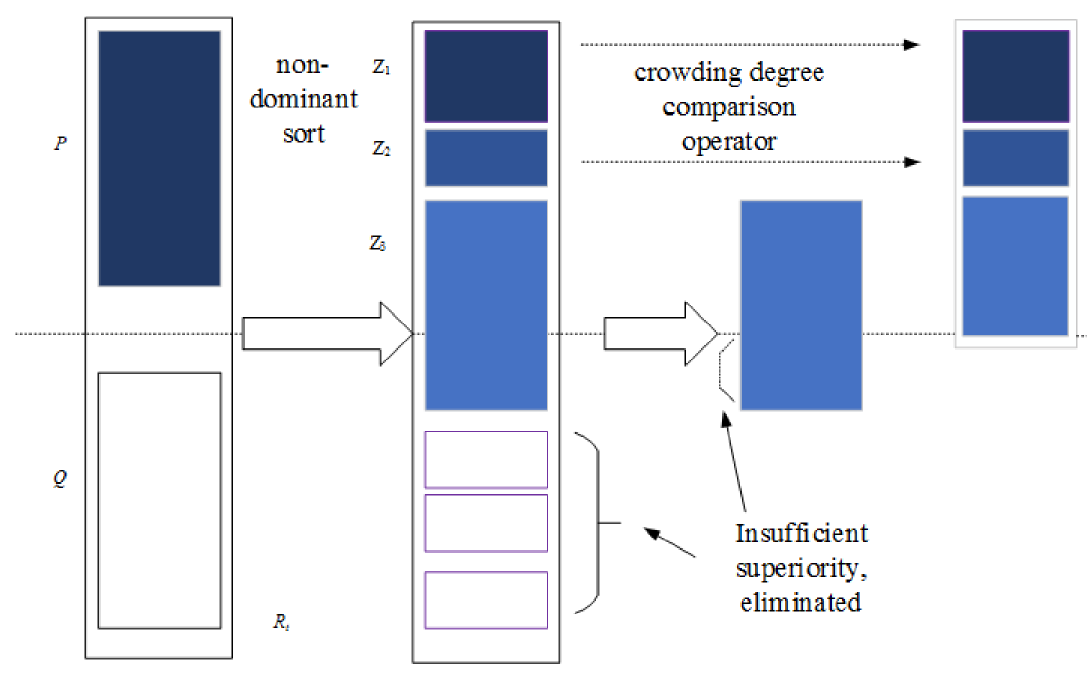
Fig 3. Elite retention process.